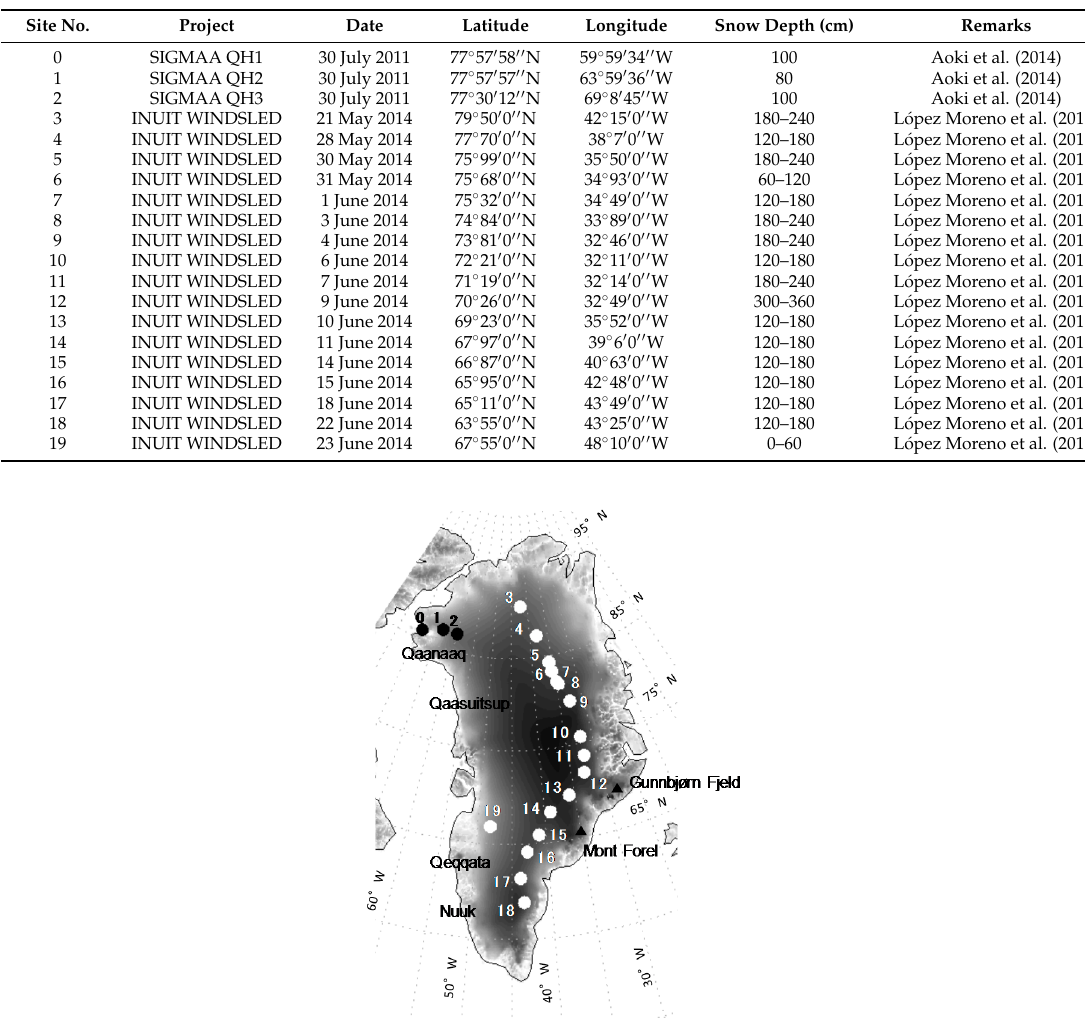
Table 1. Descriptions of field observation sites.